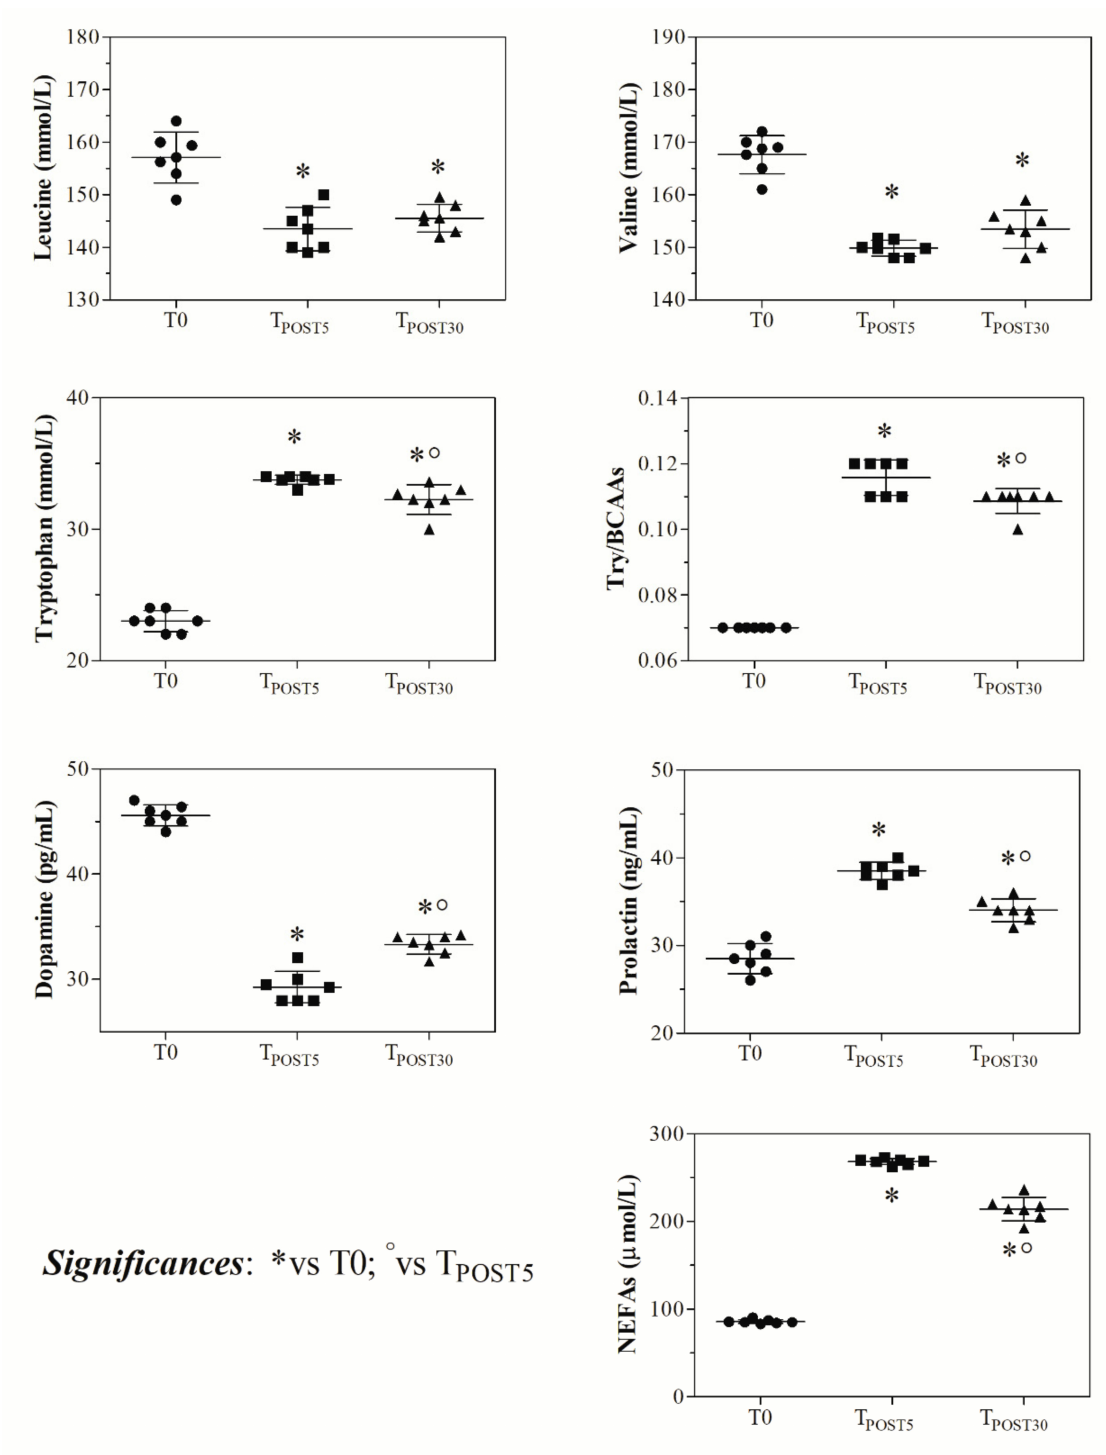
Figure 2. Blood lactate and glucose concentration, serum total protein, and rectal temperature values measured in each competing horse before the exercise event (T0), at the end of the competition stage (5 min ± 10 s) following the cessation of the exercise, T POST5 ), and 30 min after the end of the competition (T POST30